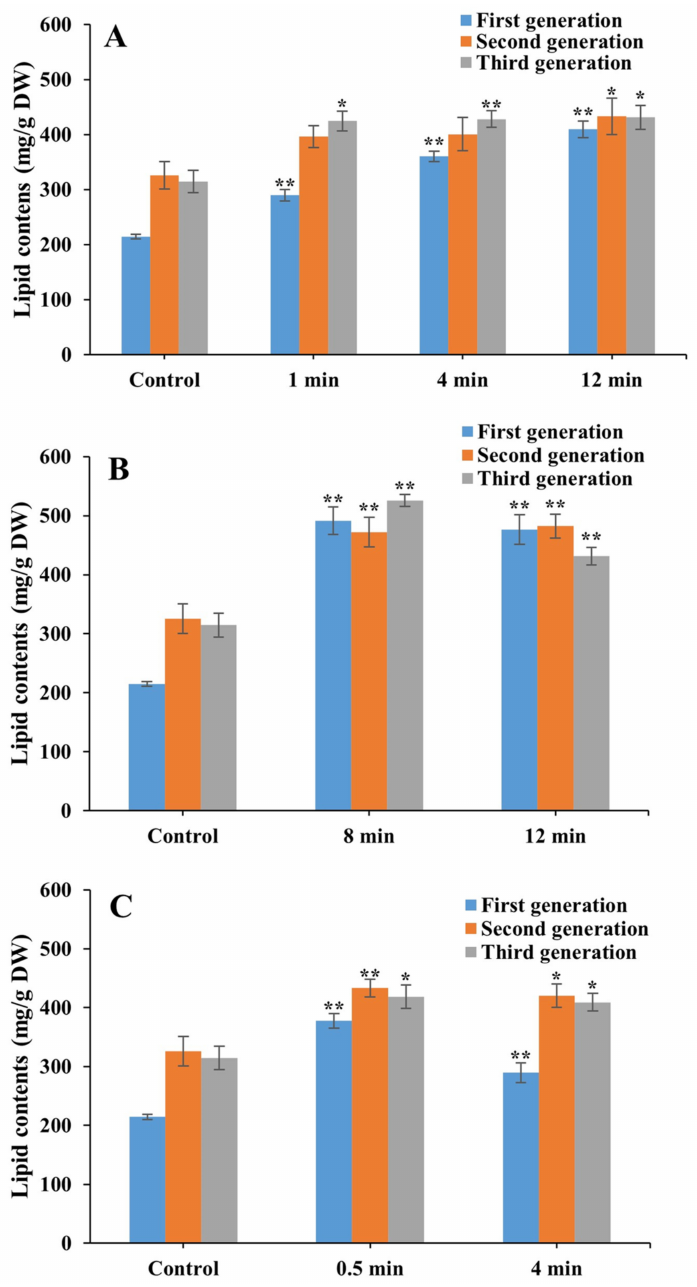
Figure 6. Lipid contents of laser mutants of Chlorella vulgaris strain FACHB 9 treated with He–Ne ( A ), Nd:YAG ( B ), and SC ( C ) cultured under heterotrophic cultivation for 21 days (three generations). Data are presented as mean ± standard errors ( n = 3). Symbols “*” and “**” indicate statistically significant differences compared to controls at p < 0.05 and p < 0.01,